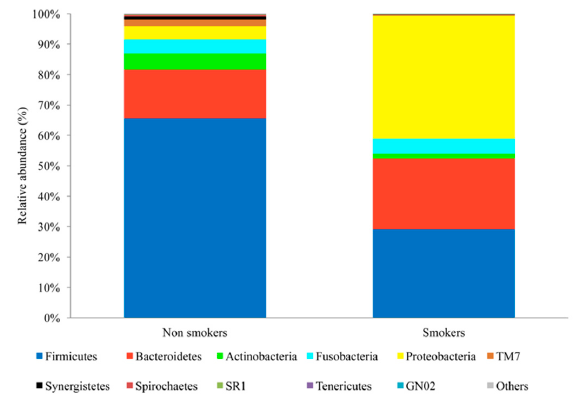
Figure 2. Taxonomic composition of nonsmokers and smokers at the phylum level. FASTA files were used to determine the taxonomy composition of each sample with a 97% similarity threshold using the Greengenes reference dataset.